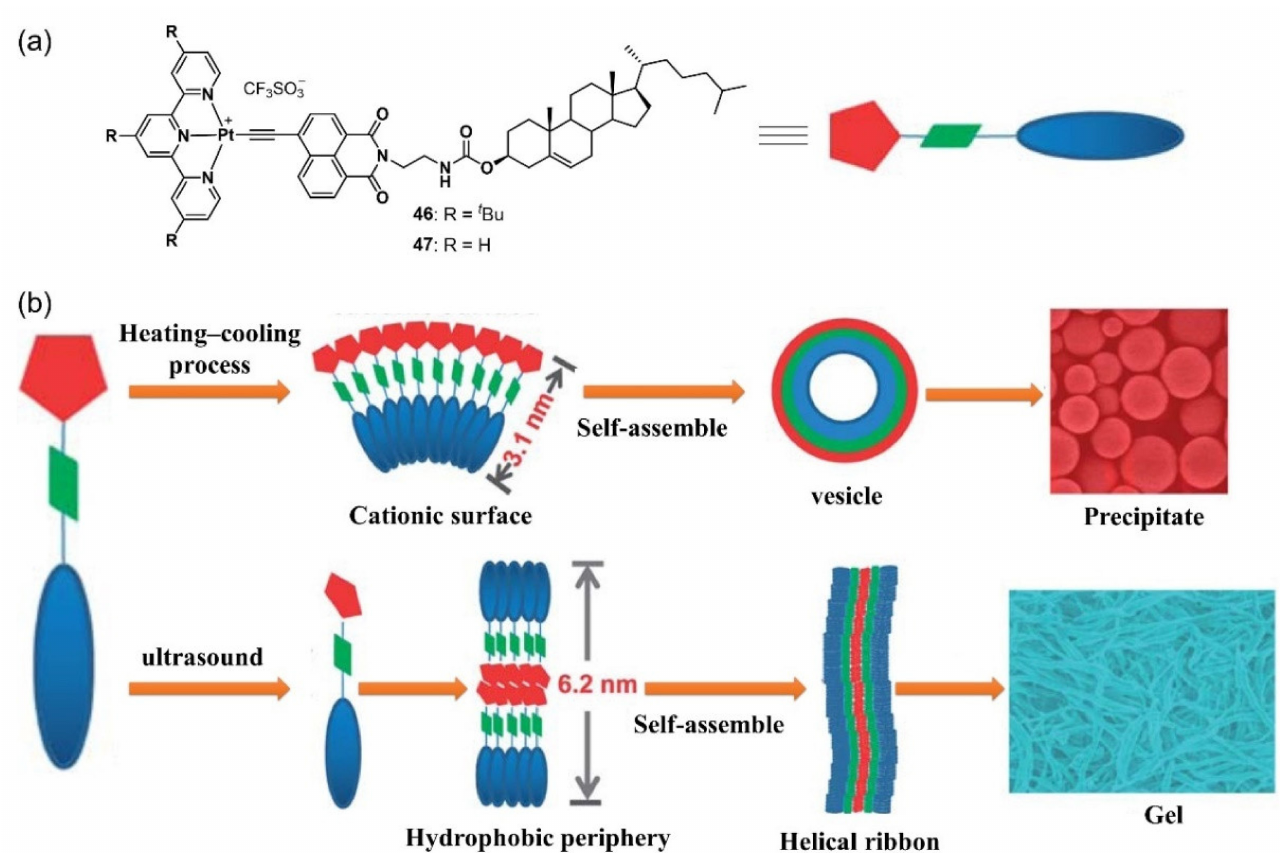
Figure 21. ( a ) The molecular structure of the gelators 46 and 47 . ( b ) A schematic of the mechanism of gelation via a self-assembly process in the sonicated gel 46 . Reprinted with permission from Ref. [84]. Copyright (2013), Royal Society of